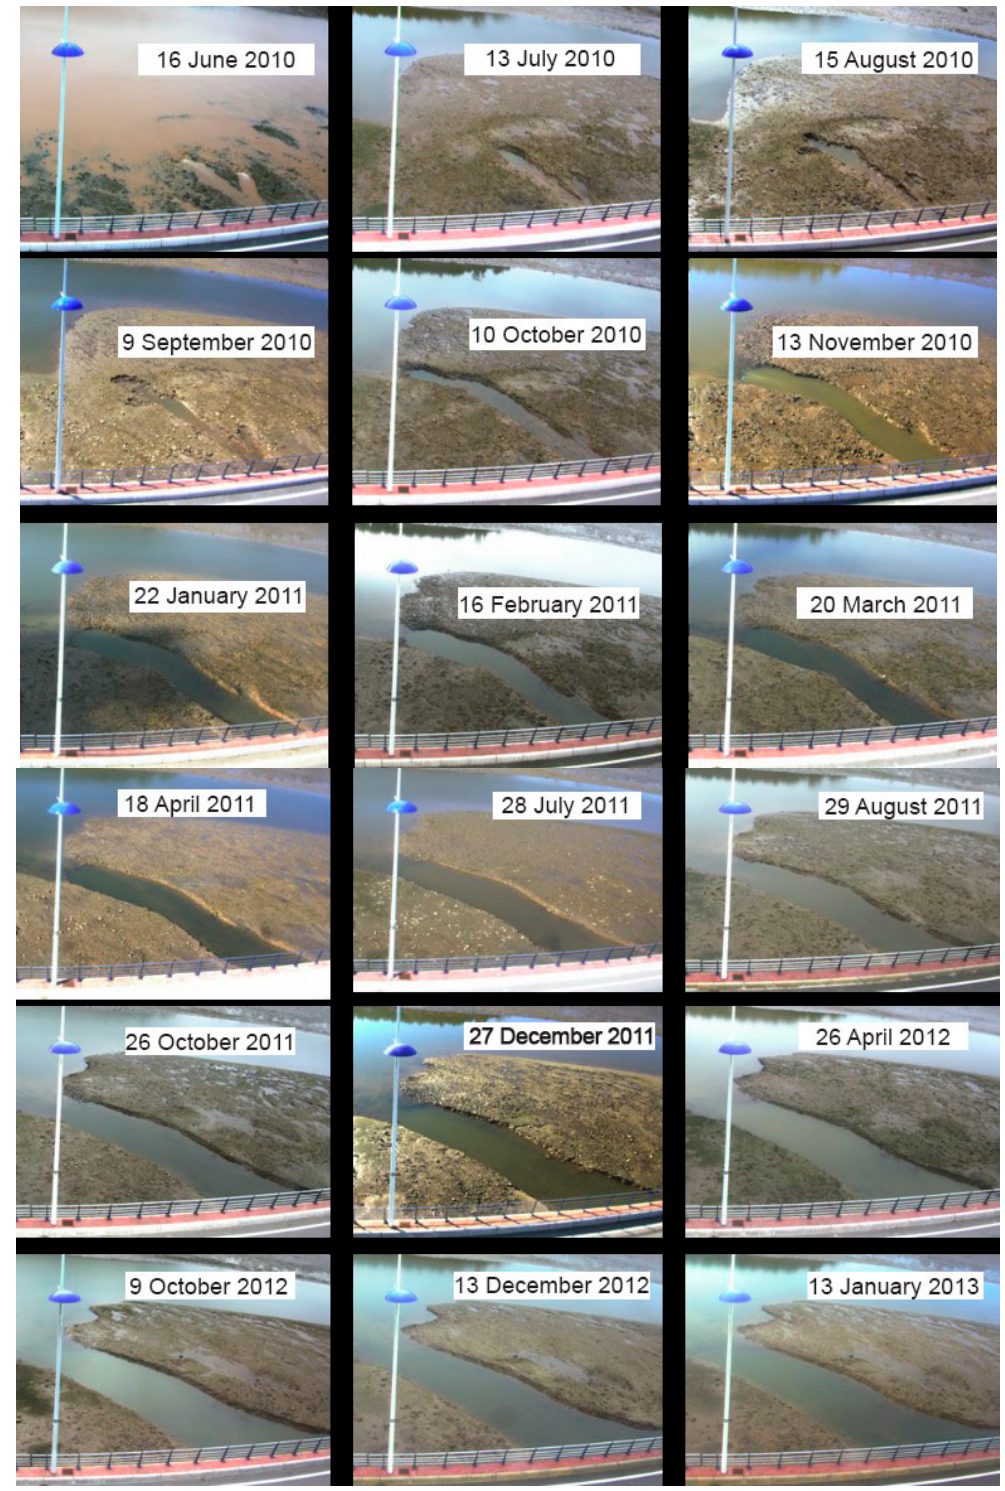
Figure 10. Development of the secondary channel as of June 2010 up to January 2013.